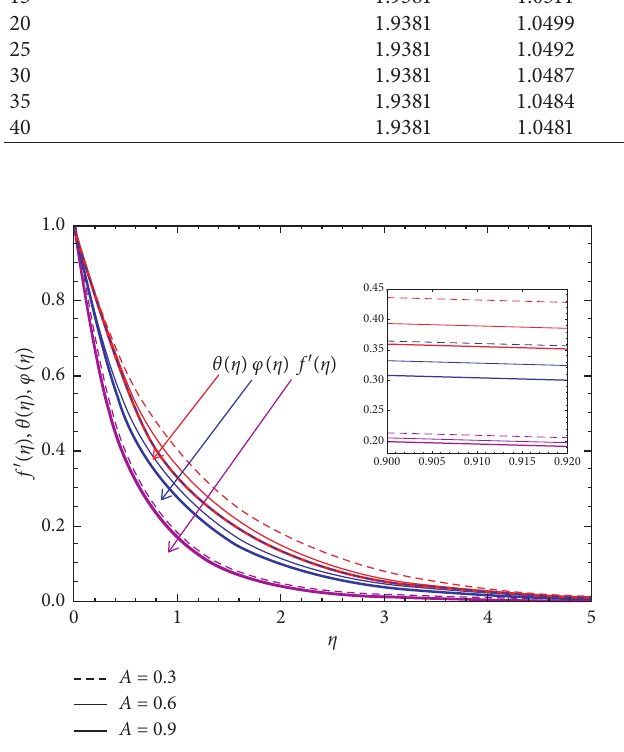
on velocity gradient, p